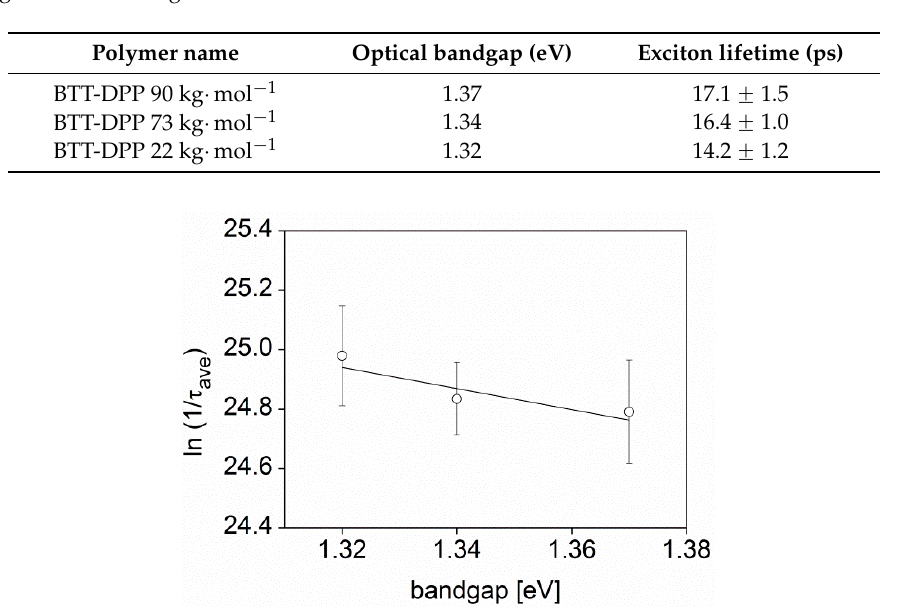
Table 2. Optical bandgaps and exciton lifetimes of BTT-DPP polymer films with differing number average molecular weights.